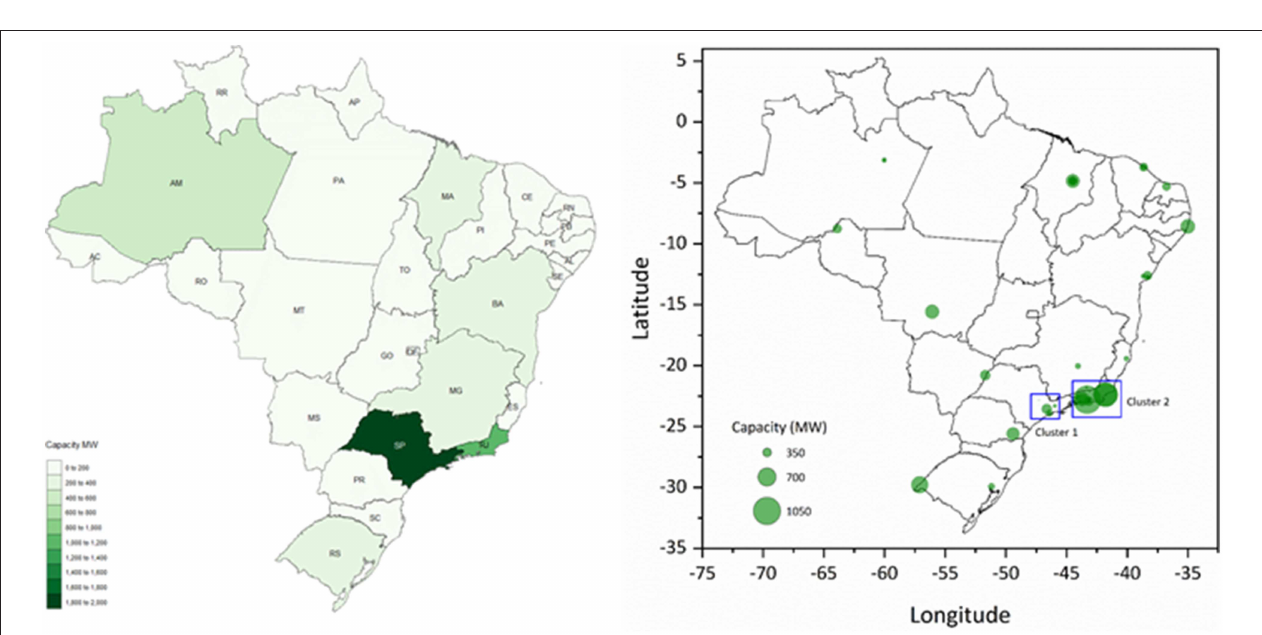
FIGURE 7 | Location and capacity of Power Plant (Natural